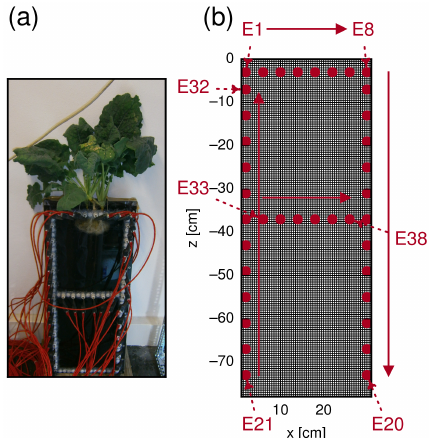
Figure 1. (a) Experimental setup of plant root systems in water filled rhizotron. (b) Corresponding finite-element grid used for elec- trical modeling and imaging. Red dots indicate position of elec- trodes. Red arrows indicate the ascending order of electrode num- bering, some of which are marked using the notation